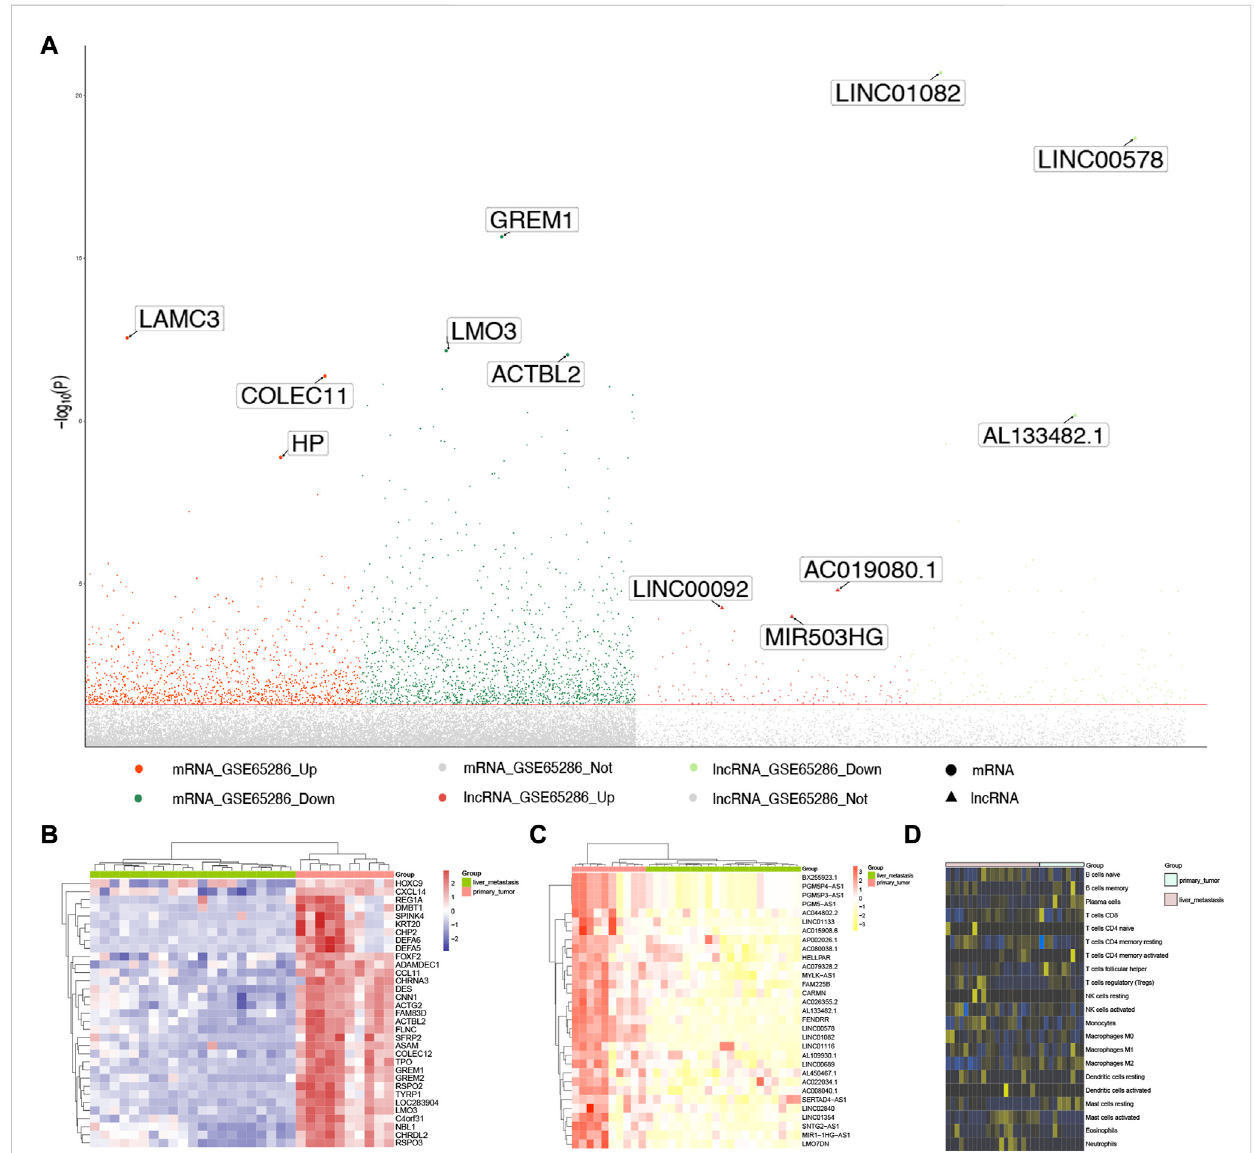
FIGURE 2 Expression disorders of SI-NETs. (A) Manhattan plot for DEGs and DElncRNA. The three most signi fi cantly DEGs and DElncRNA are marker and labeled with their names. (B) Hierarchical clustering dendrograms of the expression patterns of DEGs that distinguish between patients with primary and metastatic SI-NETs. (C) Hierarchical clustering dendrograms of the expression patterns of DElnRNA that distinguish between patients with primary and metastatic SI-NETs. DEGs: differentially expressed genes, DElncRNA: differentially expressed lncRNA, SI-NETs: small intestine neuroendocrine tumors. (D) In fi ltration of immune cells between primary and metastatic